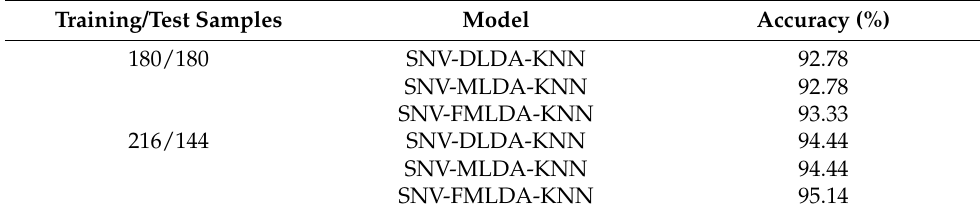
Table 2. Accuracies of tea grade recognition system under different numbers of training/test